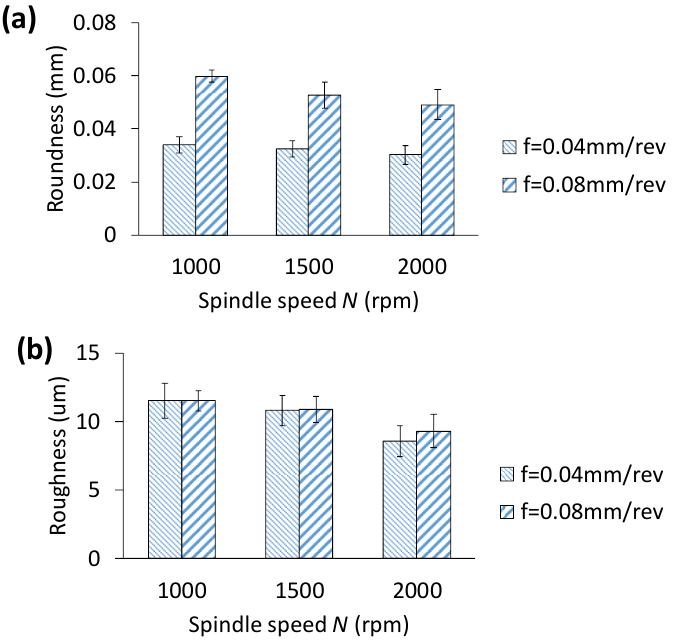
Figure 10. Effect of feedrate and spindle speed feedrate on ( a ) hole roundness and ( b ) surface roughness.